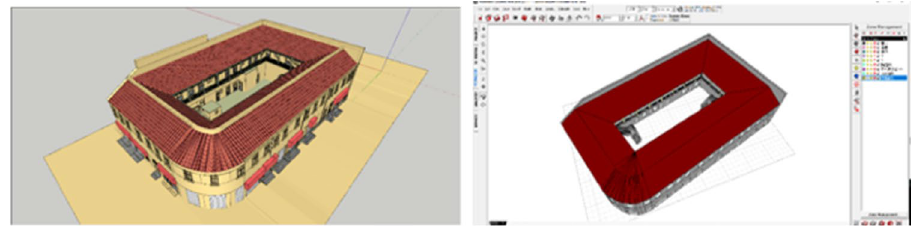
Figure 4. The building models (left) and performance simulation through Ecotect software